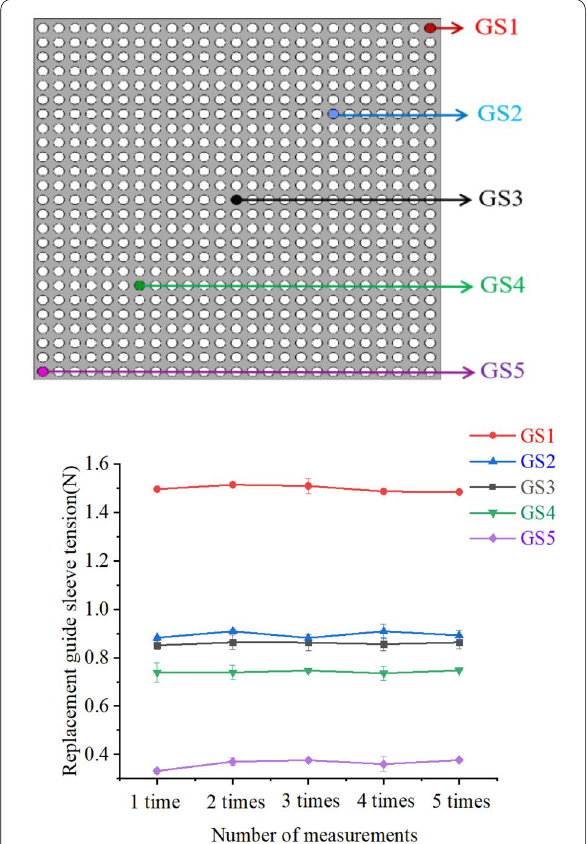
Figure 6 Tensile force measurement of the replacement guide sleeve